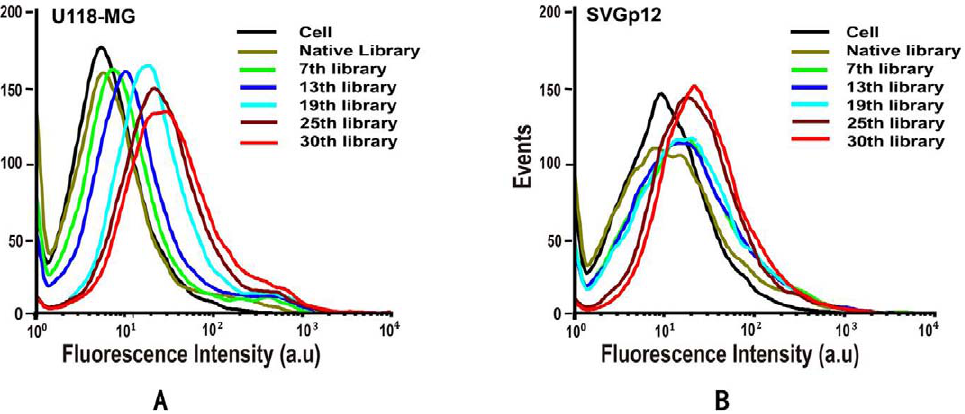
Figure 2. The binding affinity assay of the enriched pools with U118 MG and SVGp12 cells. (A) The fluorescence intensity of U118-MG cells binding with selected pools increased gradually as the selection progressed, indicating that the enhanced binding affinity of enriched pools. (B)The selected pools also showed increased affinity with SVGp12 cells, but the response was apparently weaker than with U118-MG cells. Final concentration of FAM-labeled ssDNA pools was 250 nM in binding buffer.